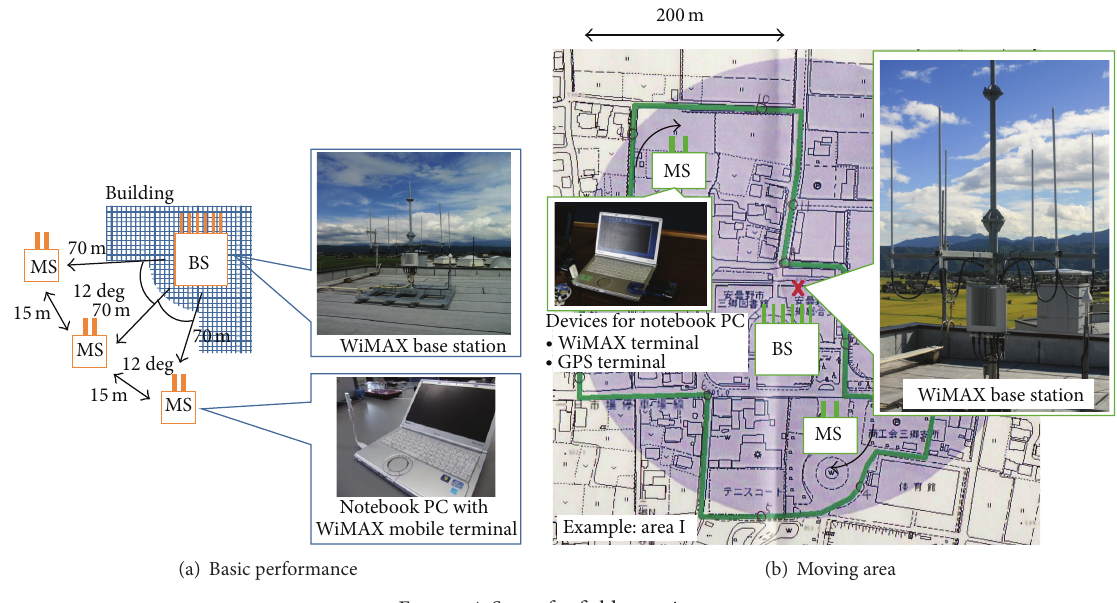
Figure 4: Setup for field